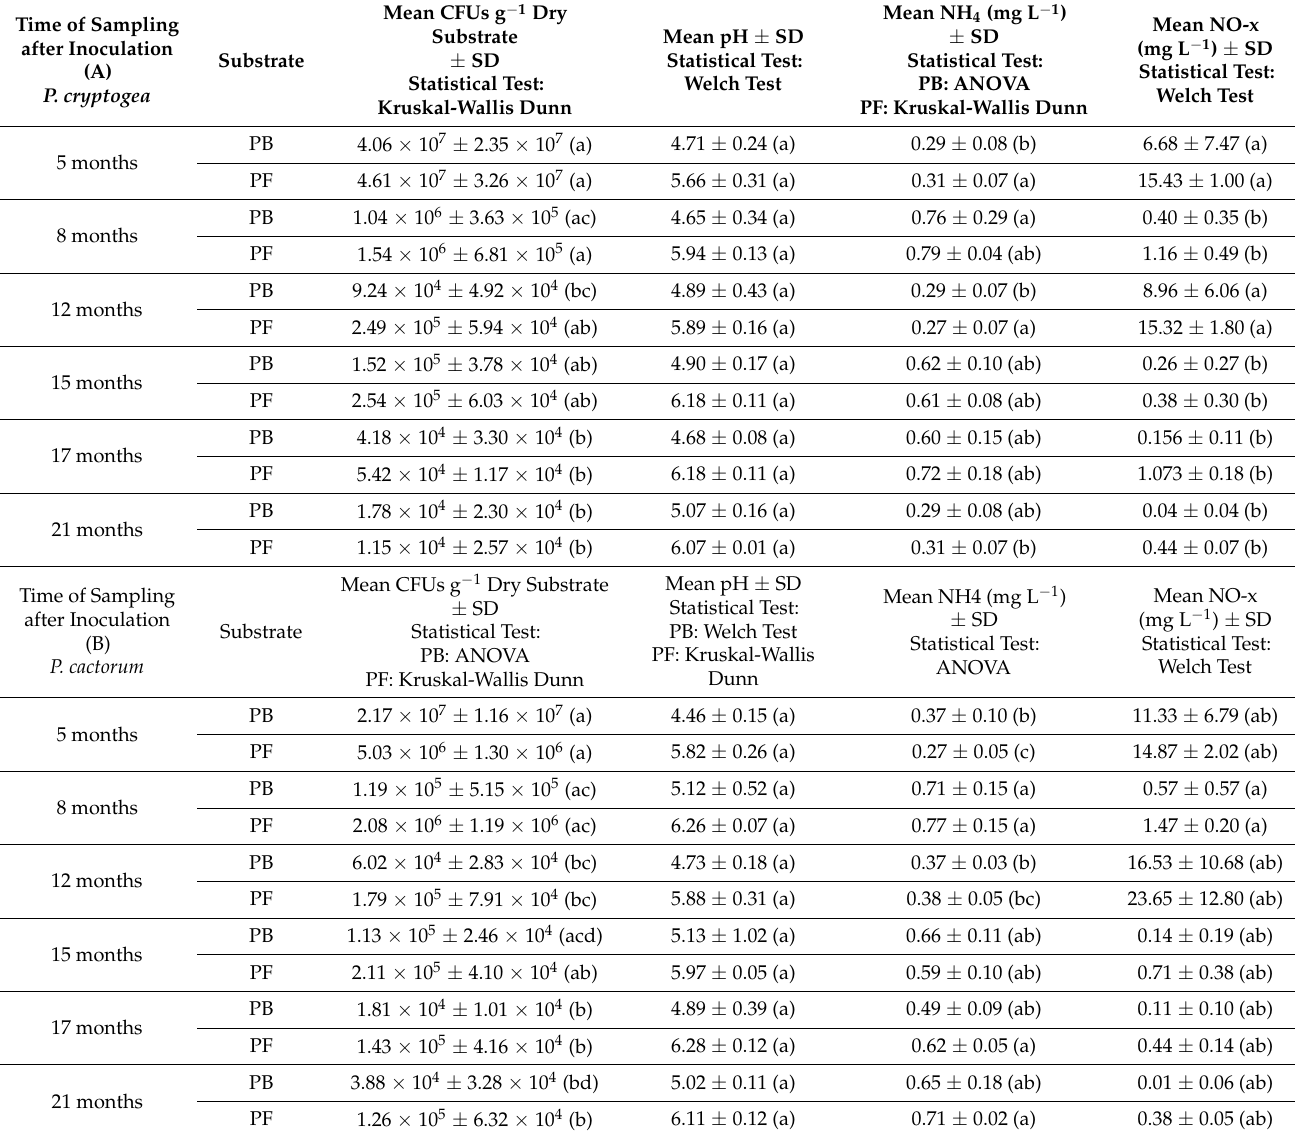
Table 1. Data collected during soil samplings of Phytophthora cryptogea (A) and P. cactorum (B), respectively, in peat-based (PB) and peat-free (PF) substrates over 21 months; statistical tests used for the analysis of significant multiple comparisons differences among sampling dates. Different letters indicate significant differences between sampling dates after inoculation ( p <